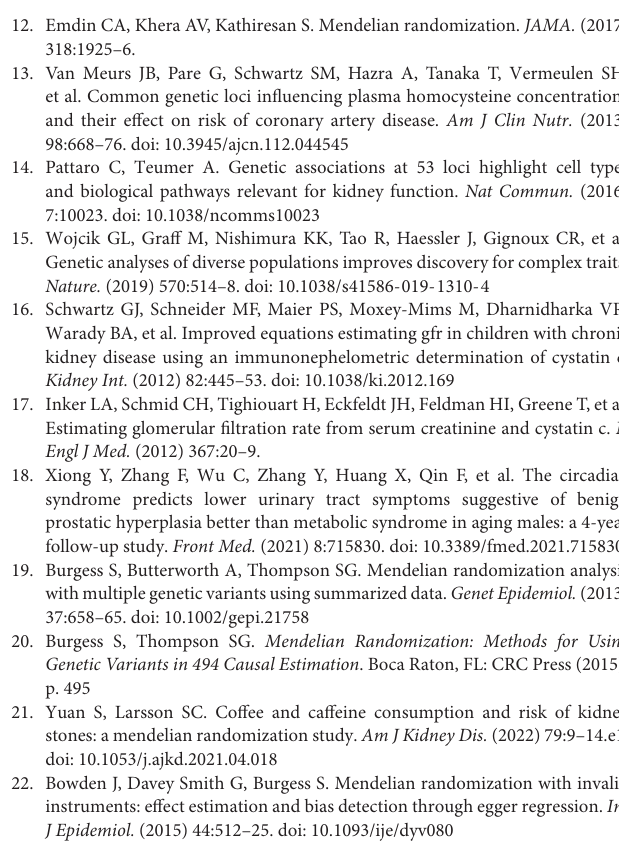
project with diabetic patients. (B) Results of the leave-one-out analyses in the CKDGen project excluding patients with diabetes. SD, standard deviation; Hcy, homocysteine; eGFR, estimated glomerular filtration rate. Supplementary Figure 2 | The results of Mendelian randomization (MR) analyses of causal associations between each Hcy SNP and eGFR. (A) Forest plot of the MR analyses in the CKDGen project with diabetic patients. (B) Forest plot of the MR analyses in the CKDGen project excluding patients with diabetes. Hcy, homocysteine; eGFR, estimated glomerular filtration rate; SNP, single nucleotide polymorphism. Supplementary Figure 3 | The leave-one-out sensitivity analyses between 1-SD Hcy increase and CKD. (A) Results of the leave-one-out analyses in the CKDGen project. (B) Results of the leave-one-out analyses in the Population Architecture using Genomics and Epidemiology (PAGE) project. SD, standard deviation; Hcy, homocysteine; CKD, chronic kidney disease. Supplementary Figure 4 | The results of MR analyses of causal associations between each Hcy SNP and CKD. (A) Forest plot of the MR analyses in the CKDGen project. (B) Forest plot of the MR analyses in the PAGE project. Hcy, homocysteine; CKD, chronic kidney disease; SNP, single nucleotide polymorphism. Supplementary Figure 5 | Causal estimates of 1-SD Hcy increase on CKD. (A) Results of the MR analyses estimating the causal association between 1-SD tHcy increase and CKD in the CKDGen project. (B) Results of the MR analyses estimating the causal association between 1-SD tHcy increase and CKD in the PAGE project. SD, standard deviation; Hcy, homocysteine; IVW, inverse variance weighted method; OR, odds ratio; CKD, chronic kidney disease. Supplementary Table 1 | Single nucleotide polymorphisms (SNPs) used as genetic instruments in this study. SNPs, single nucleotide